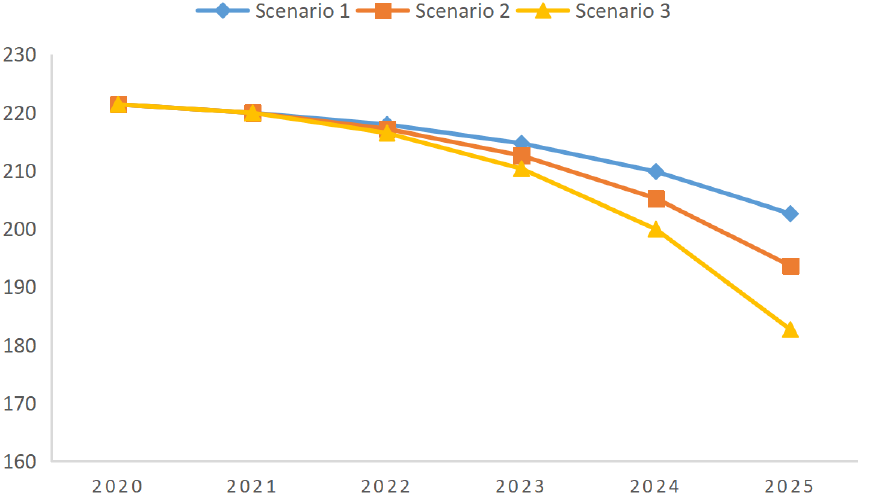
Figure 10. Emission reduction of the bicycle-sharing substitution effect (10,000 tons).